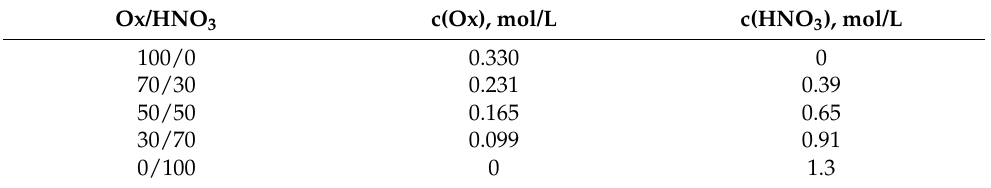
Table 1. Corresponding oxalic and nitric acid concentrations in different acid